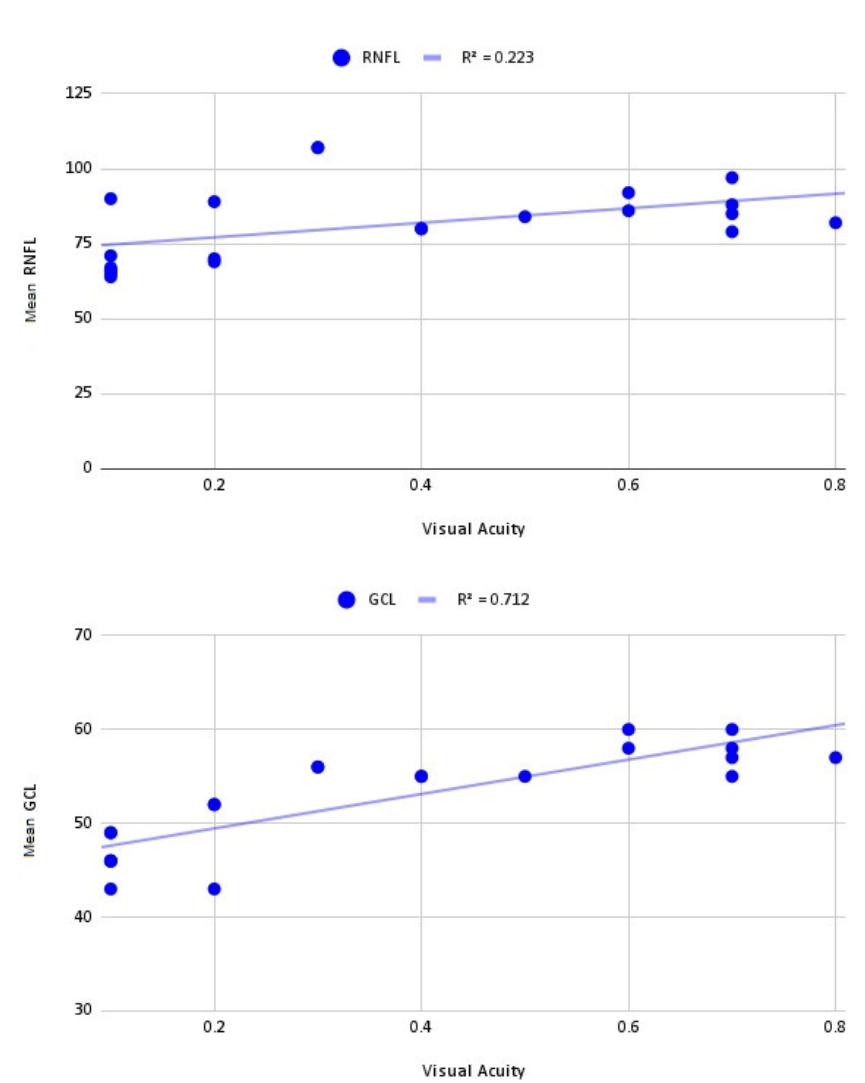
Figure 1. Correlation between mean retinal nerve fiber layer—ganglion cell layer thickness and visual acuity.